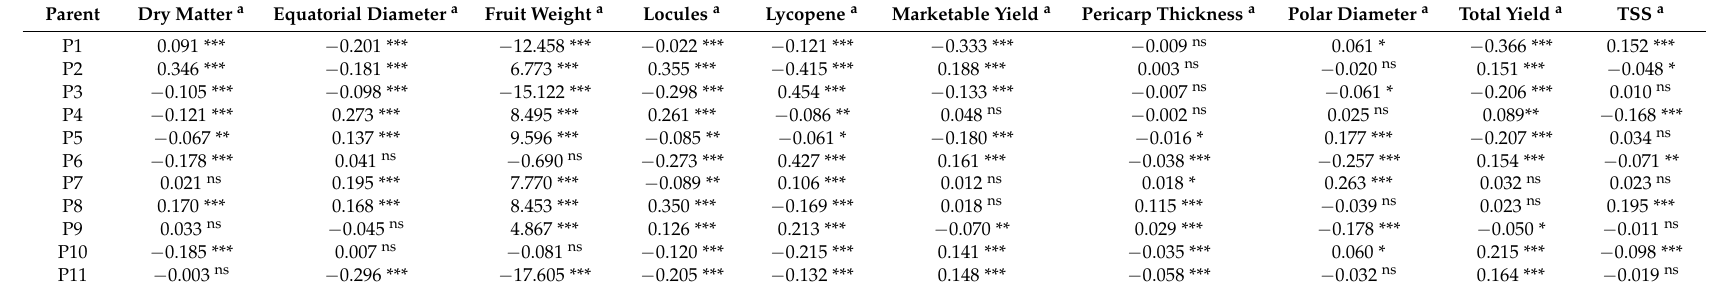
Table 4. The estimates of general combining ability (GCA) for the parent genotypes (11) for the ten descriptors studied under the influence of leaf curl virus.